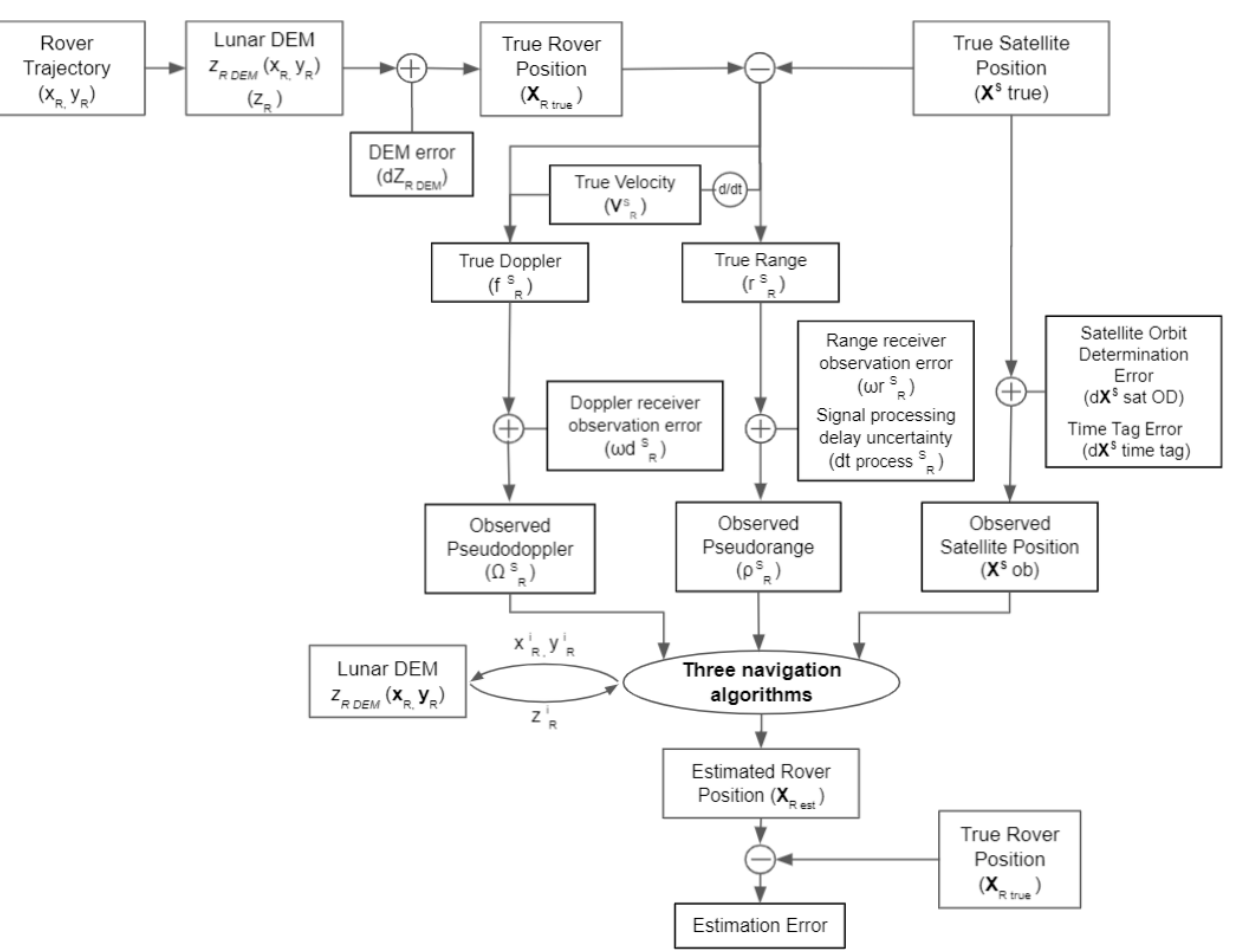
Figure 5. Simulation overview.